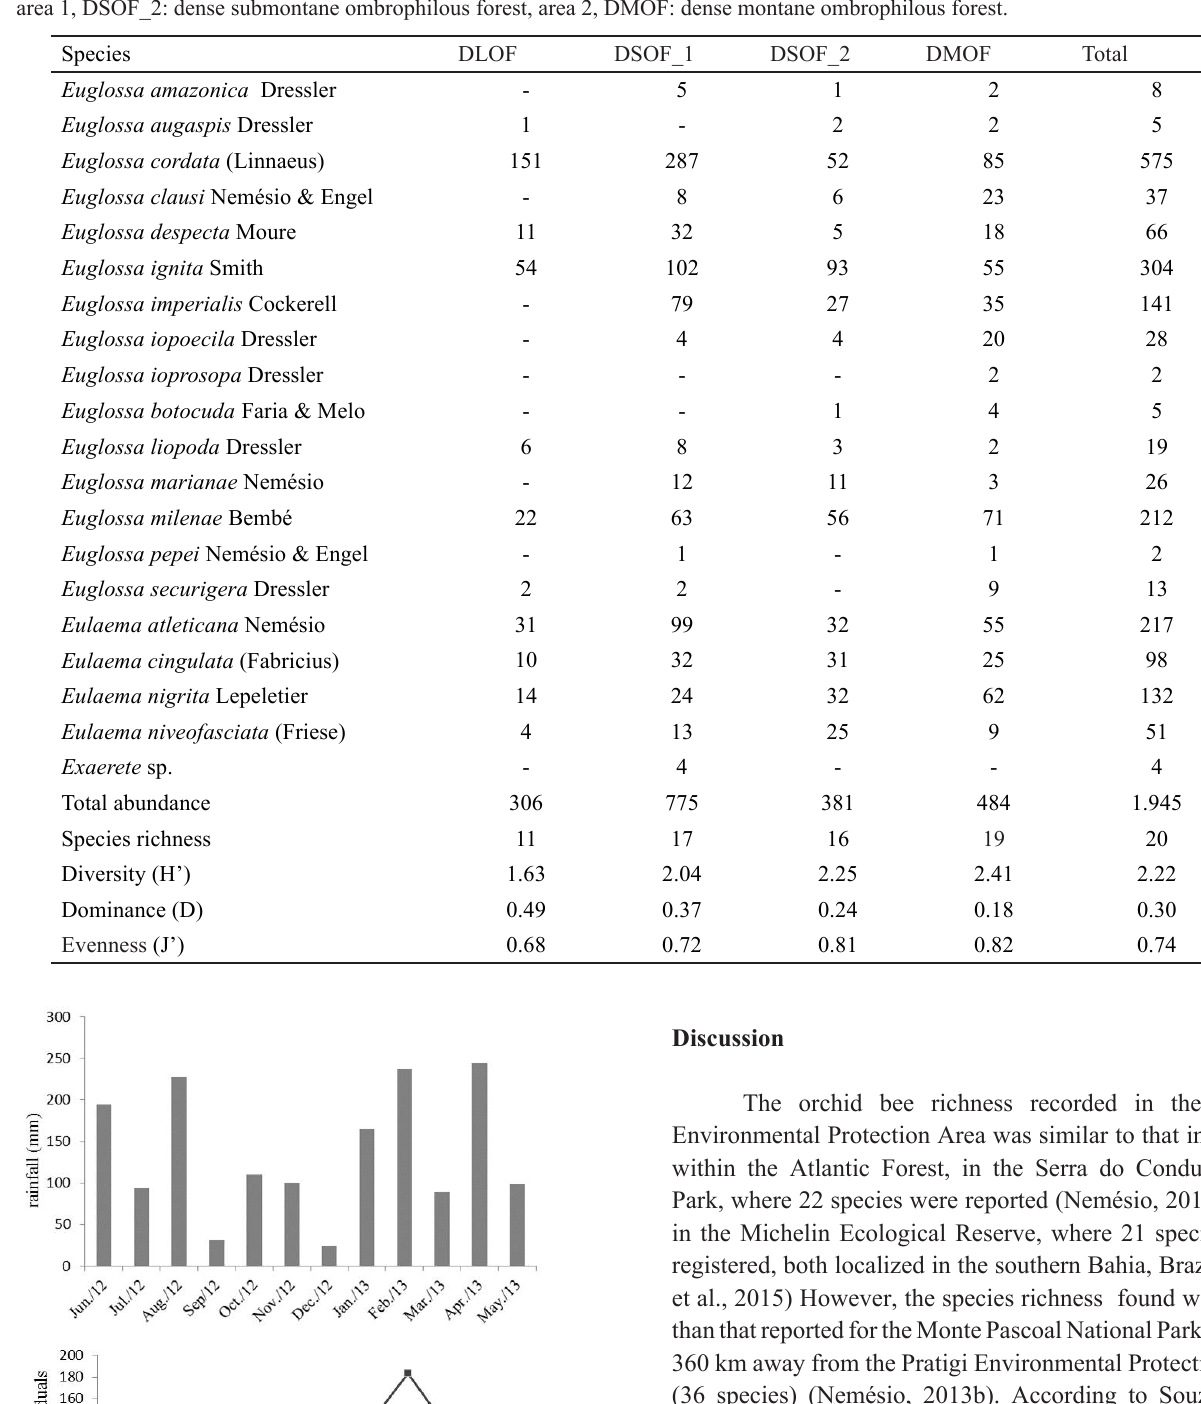
Table 1 . Species composition, abundance, richness, diversity and evenness in Euglossini bee communities in different phytophysiognomies of the Atlantic Forest in southern Bahia, Brazil. DLOF: dense lowland ombrophilous forest), DSOF_1: dense submontane ombrophilous forest,